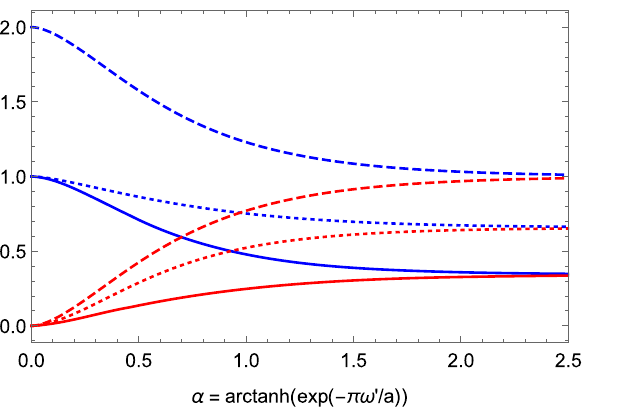
Fig. 7 State ρ I , II – Entanglement of